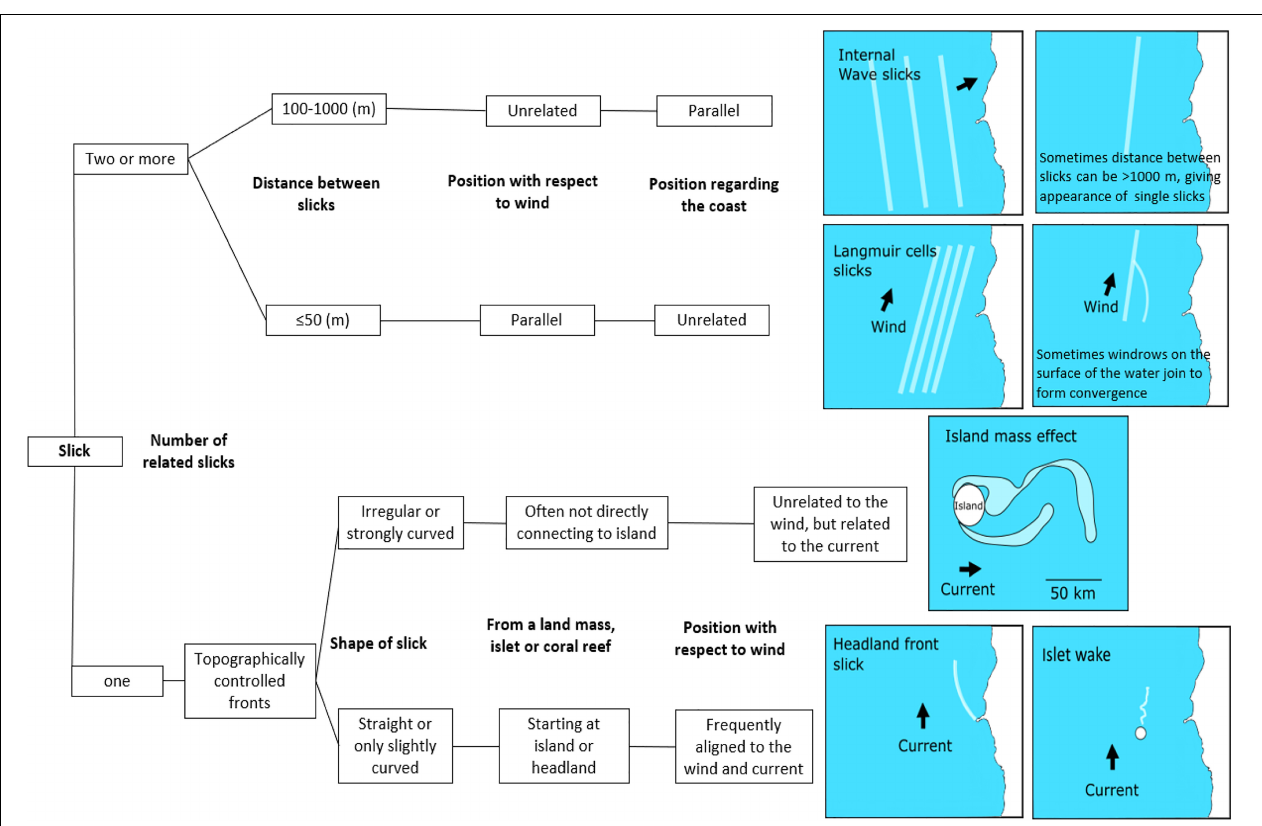
FIGURE 3 | Decision tree with the possible processes and main characteristics that generate slicks. Diagram shows images that were modified based on examples by Katherine Smith 2019: (https://www.integratedecosystemassessment.noaa.gov/regions/hawaii/hi-surface-slicks). Note for single slicks: In the case of finding a slick that is positioned parallel to the coast and unrelated to the wind, it appears that it is a solitary internal wave, e.g., when the wave train has a wavelength of up to 16 km. In the case of finding a slick that is parallel to the wind, unrelated to the coast and has arms or Y-shaped protections, it is possible that they are amalgamation/destruction of Langmuir circulation cells by the background topography. Black arrows indicate direction of wind or currents, as